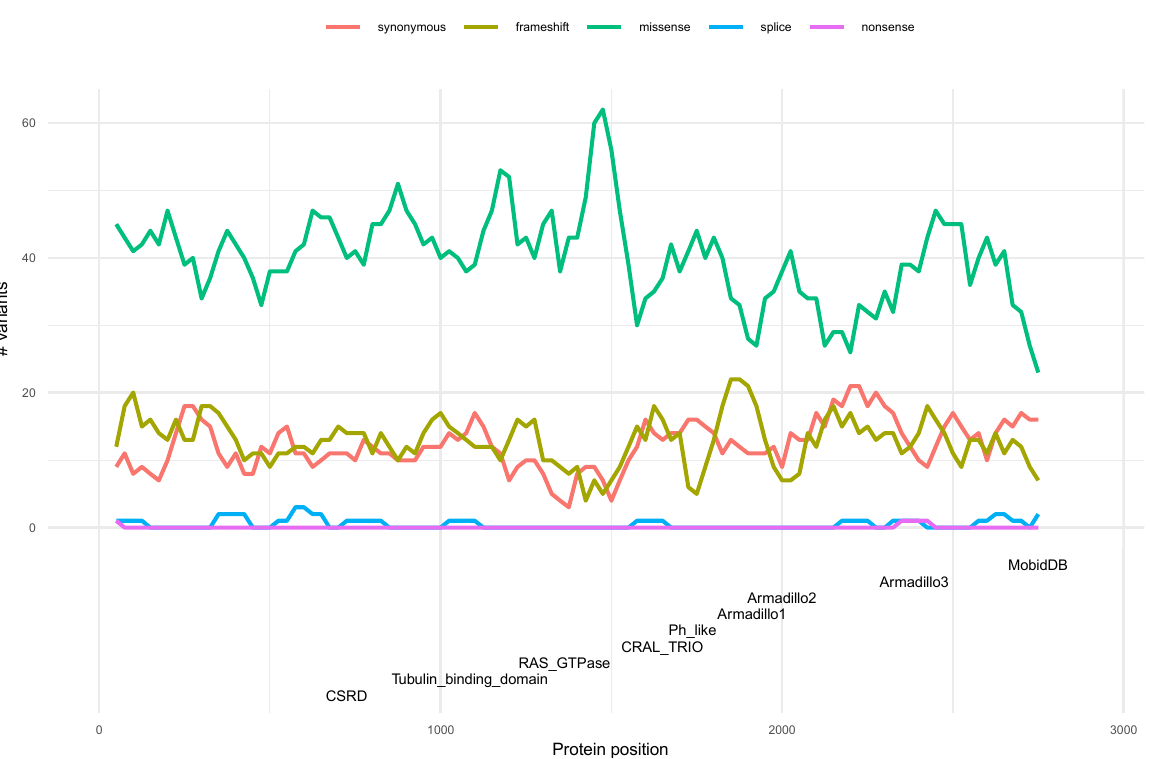
Figure 4. Variants distribution in neurofibromin. A total of 4610 variants annotated in ClinVar were used for the study. Different types of variants are represented by continuous lines using different colors. Neurofibromin protein domains are defined at the bottom.